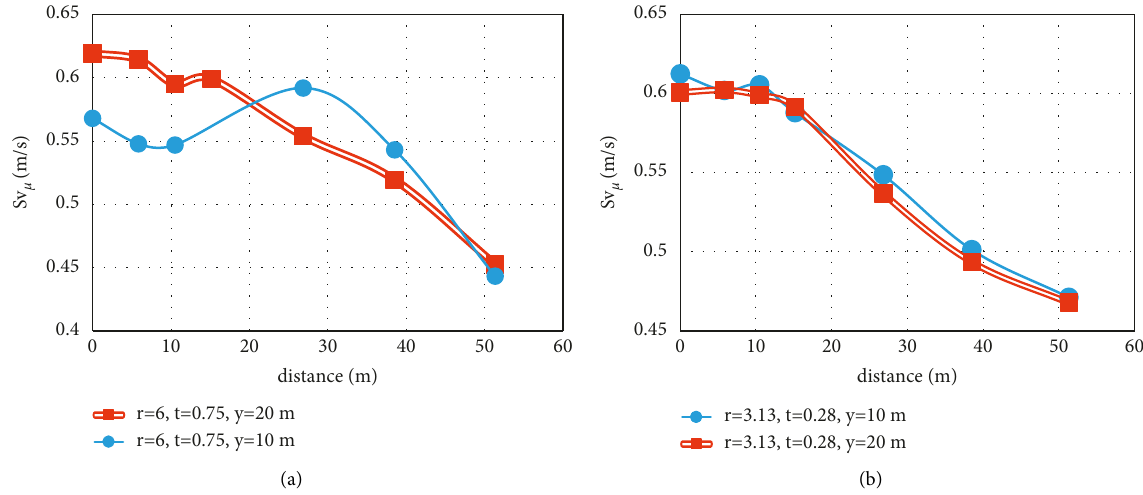
Figure 8: The effect of change in overburden depth on ground surface velocity for models (a) 4 and 5 and (b) 6 and 7 of Table 1.